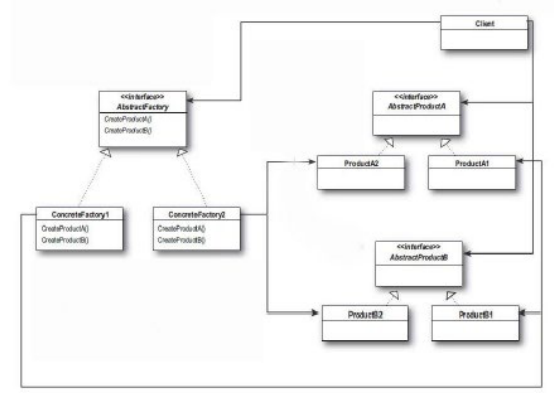
Fig. 4. Abstract Factory pattern UML diagram